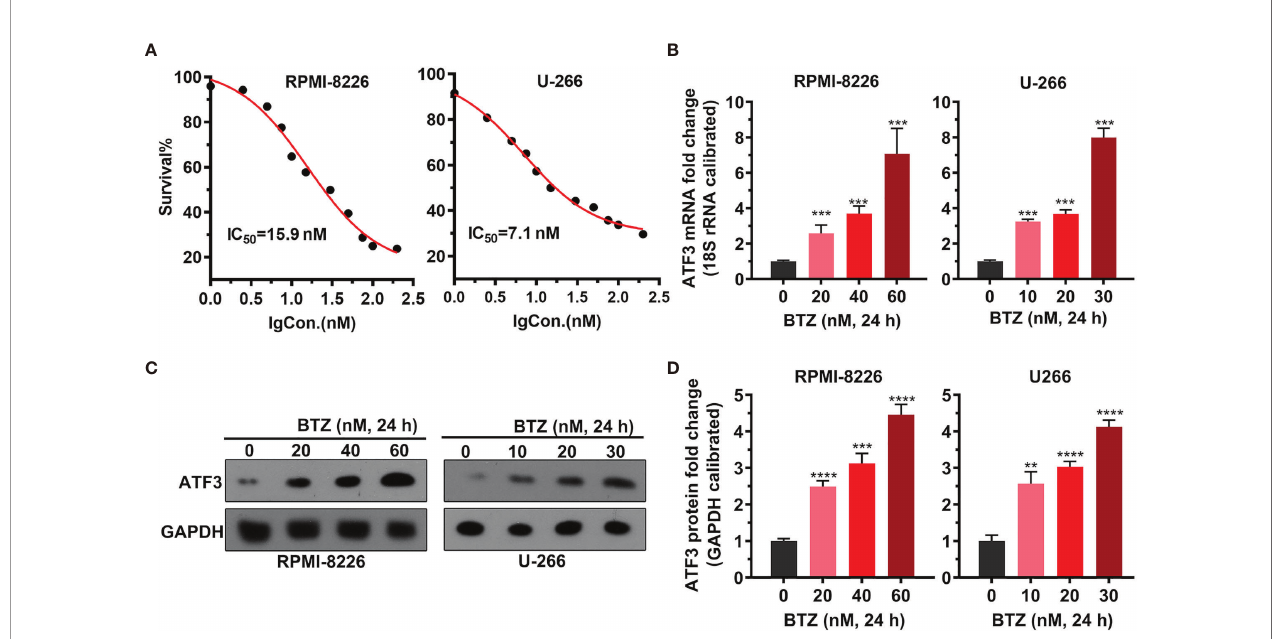
FIGURE 1 | Effects of bortezomib (BTZ) on multiple myeloma (MM) cell proliferation and ATF3 expression. (A) MM cell proliferation was assessed by MTT assays. BTZ was used to treat RPMI-8226 and U-266 cells at various doses. (B) The ATF3 mRNA level was measured by RT-qPCR in RPMI-8226 and U-266 cells treated with various doses of BTZ. One-way ANOVA was used for statistical analysis. (C) The ATF3 protein level was measured by western blotting in RPMI-8226 and U- 266 cells treated with various doses of BTZ. (D) Quanti fi cation of ATF3 band intensity, with values normalized to GAPDH. Data were analyzed by one-way ANOVA, followed by Tukey ’ s post-hoc test. **P < 0.01, ***P < 0.001, ****P < 0.0001 compared to 0